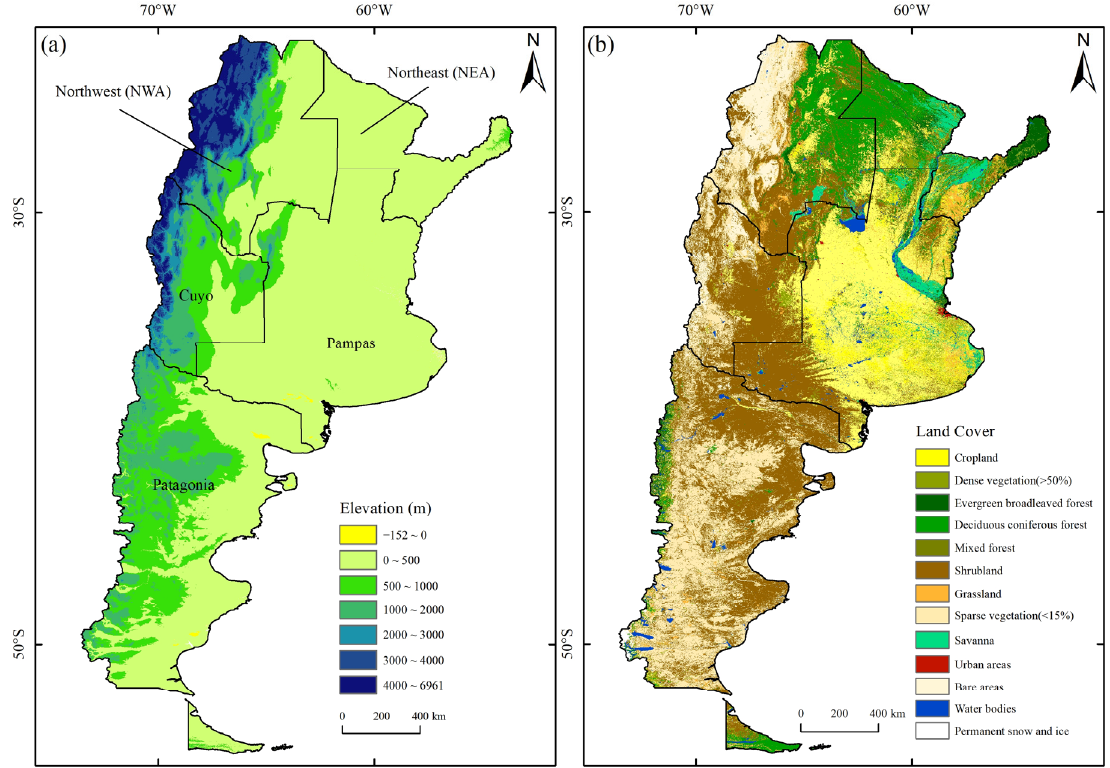
Figure 1. ( a ) Geographic distribution of the five administrative regions of Argentina. ( b ) Land cover in Argentina.